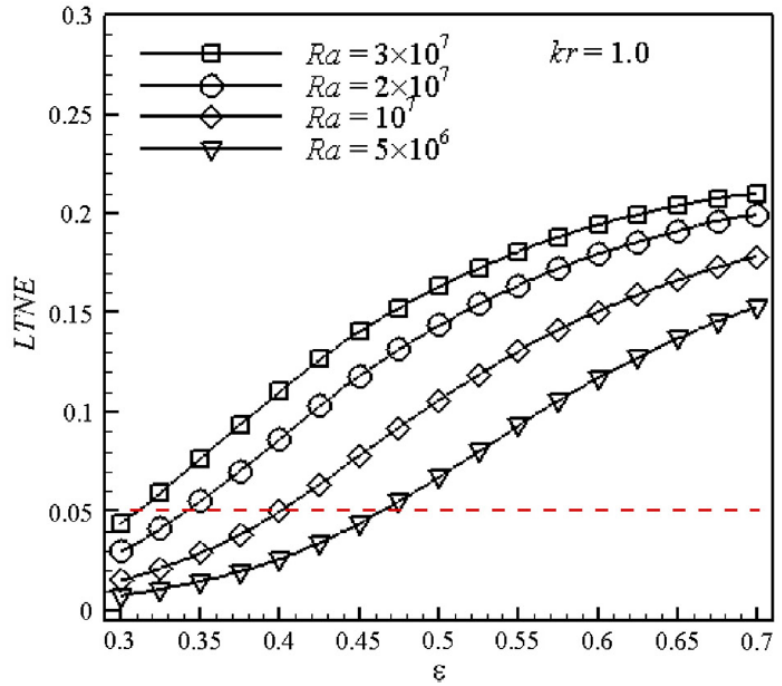
Figure 42. LTNE versus porosity ( ε ) for different Rayleigh numbers, at ( kr = 1.0), presented by Al-Sumaily et al.